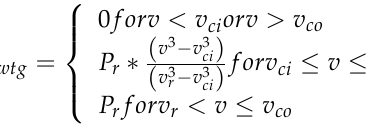
where γ is the surface roughness and is chosen to be 0.18 for the proposed location.